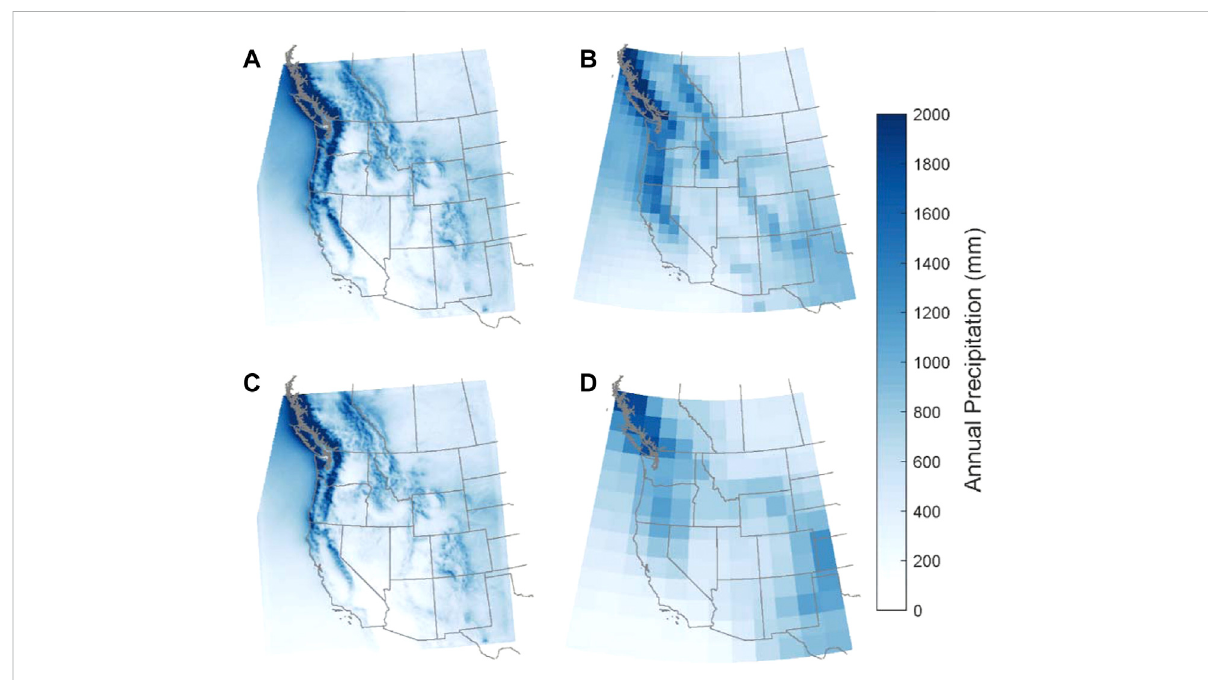
FIGURE 2 As for Figure 1 but for annual precipitation. (A – D) represent WRF/CCSM4, CCSM4, WRF/NorESM1-M, and NorESM1-M,